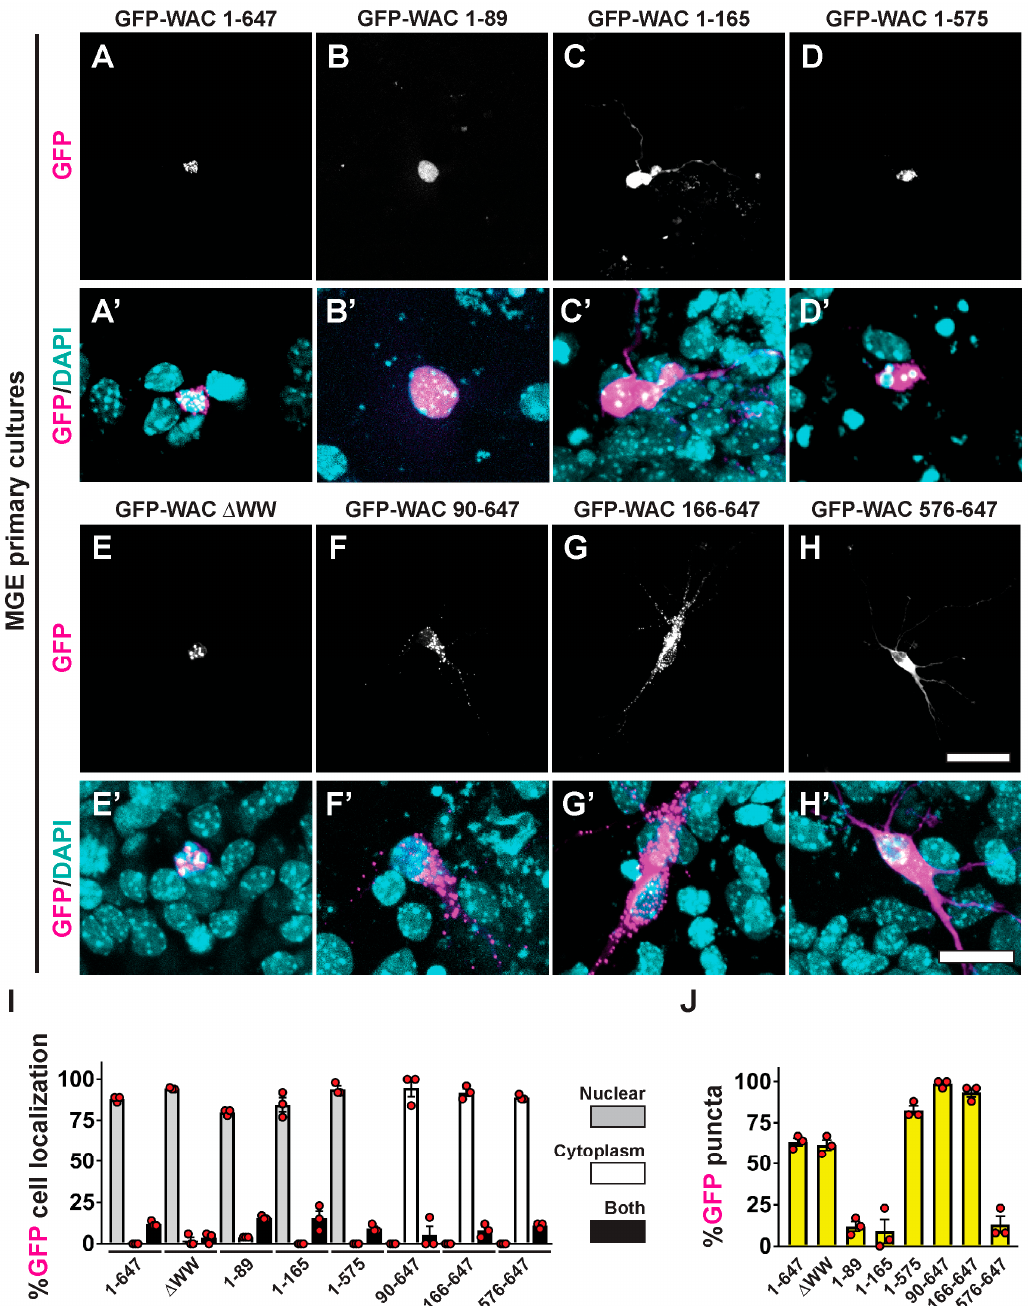
Figure 6. Distinct cellular distribution by WAC’s conserved protein domains. MGE primary neurons transfected with GFP-WAC fusion proteins were assessed for GFP localization ( A – H ) and merged with DAPI after five days in vitro ( A’ – H’ ). ( I ) Quantification of the proportion of GFP labeled cells showing nuclear and/or cytoplasmic distribution. ( J ) Quantification of the proportion of GFP-labeled cells with punctate localization. Scale bars in ( H ) = 40 µm for all top panels and ( H’ ) = 20 µm for all bottom panels.